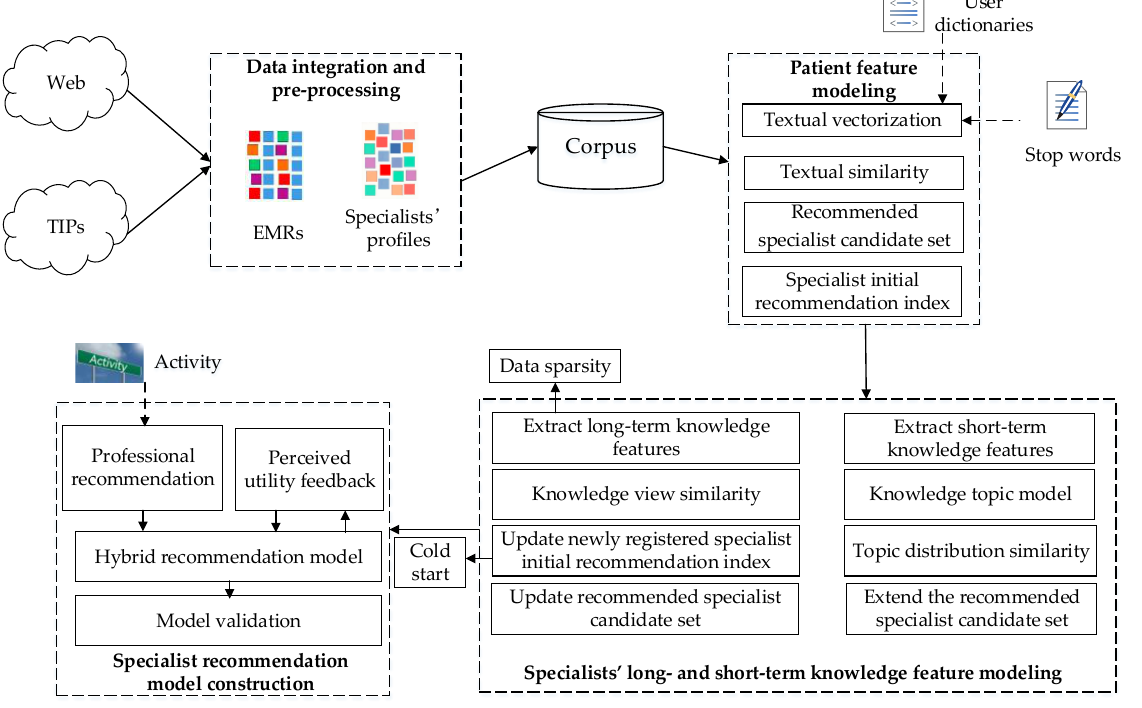
Figure 1. Telemedicine specialist recommendation